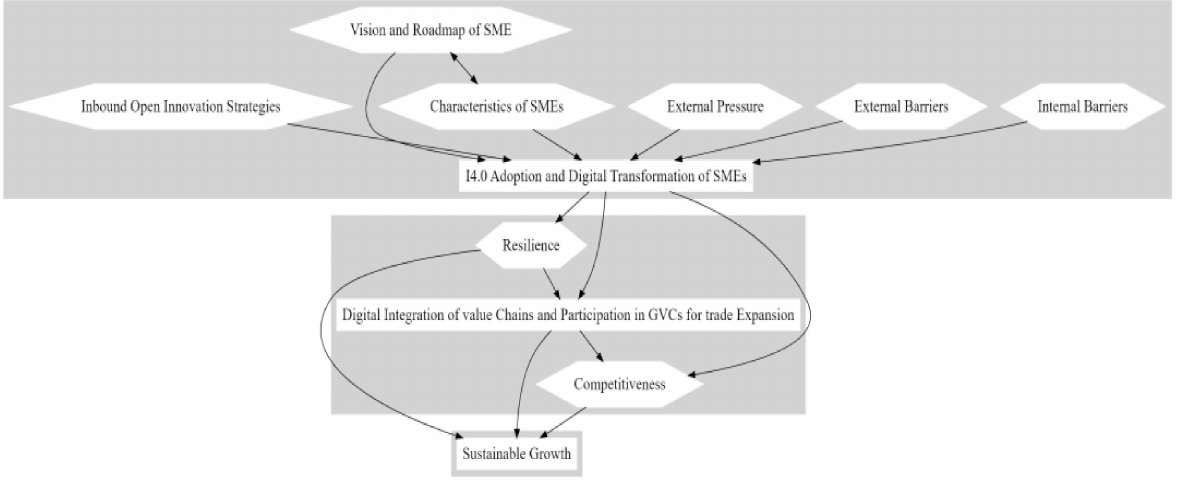
Figure 8. Conceptual framework (based on the findings of